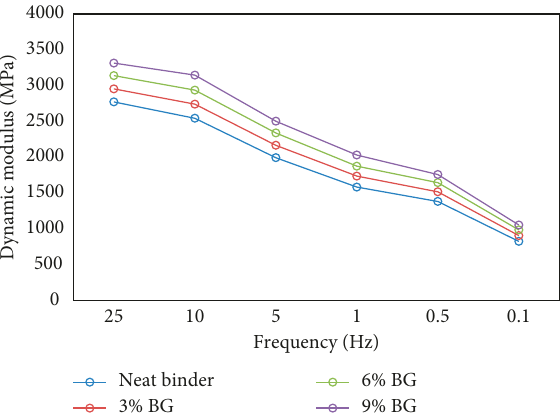
Figure 14: Dynamic modulus graph at 40 ° C.